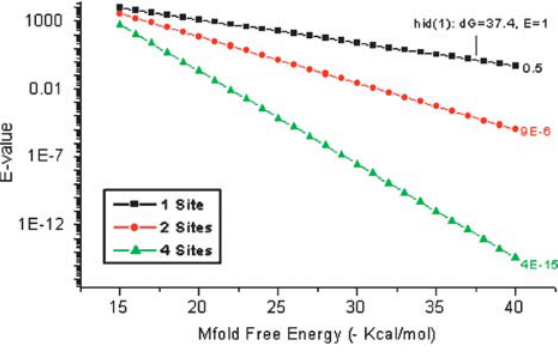
Figure 5. Statistical Evaluation of Predicted Targets Plot of E -values as a function of free energy of folding. Y-axis: logarithmic scale of E -values. X-axis: free energy of folding calculated by Mfold. Calculations for one, two, and four sites are shown separately. The position of the best bantam site in hid is shown for reference. DOI: 10.1371/journal.pbio.0000060.g005